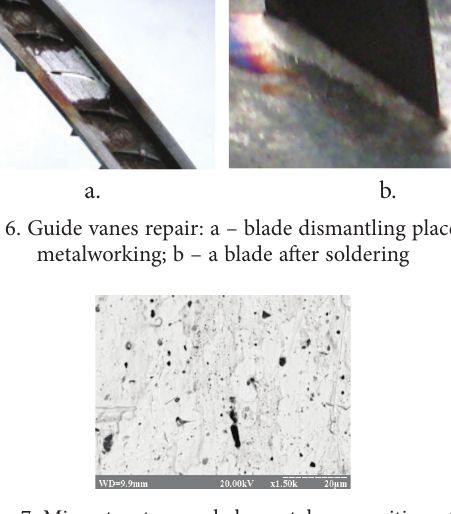
Figure 7. Microstructure and elemental composition of the solder joint sample